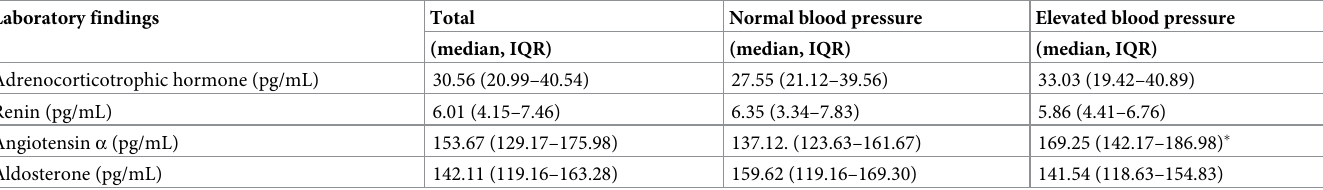
Table 6. The renin-angiotensin system in subjects with and without elevated blood pressure.